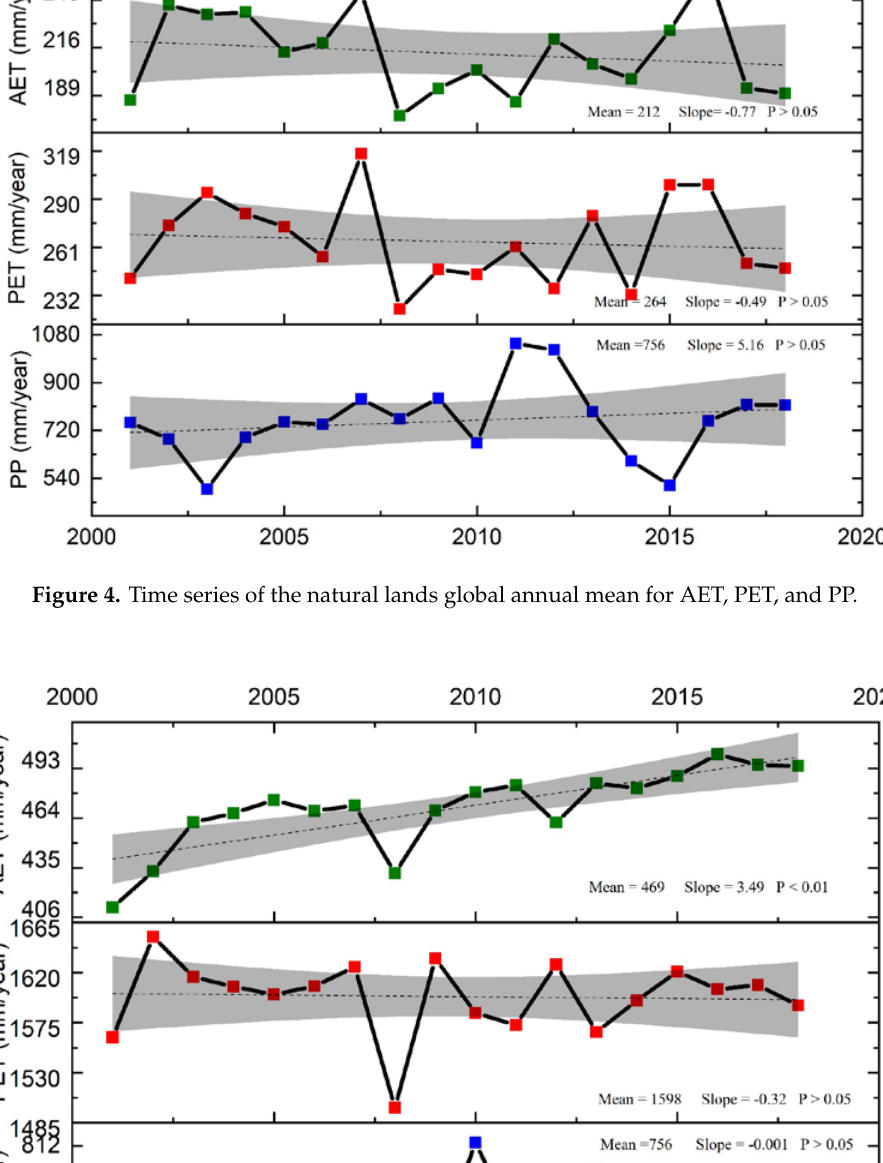
Figure 4. Time series of the natural lands global annual mean for AET, PET, and PP.